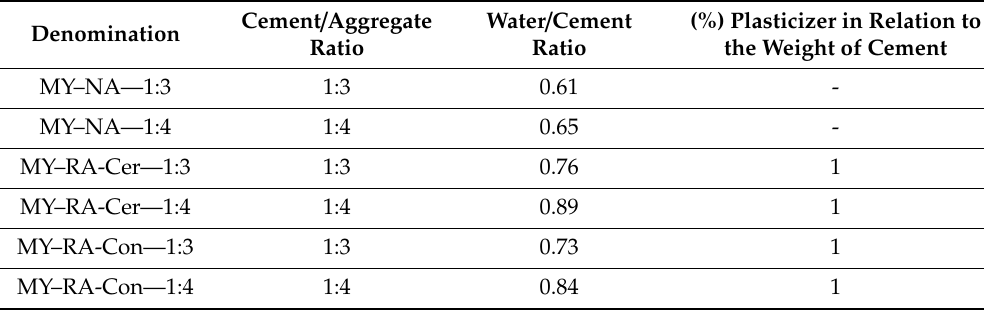
Table 5. Dosages used to make the mortar mixes. MY: cement